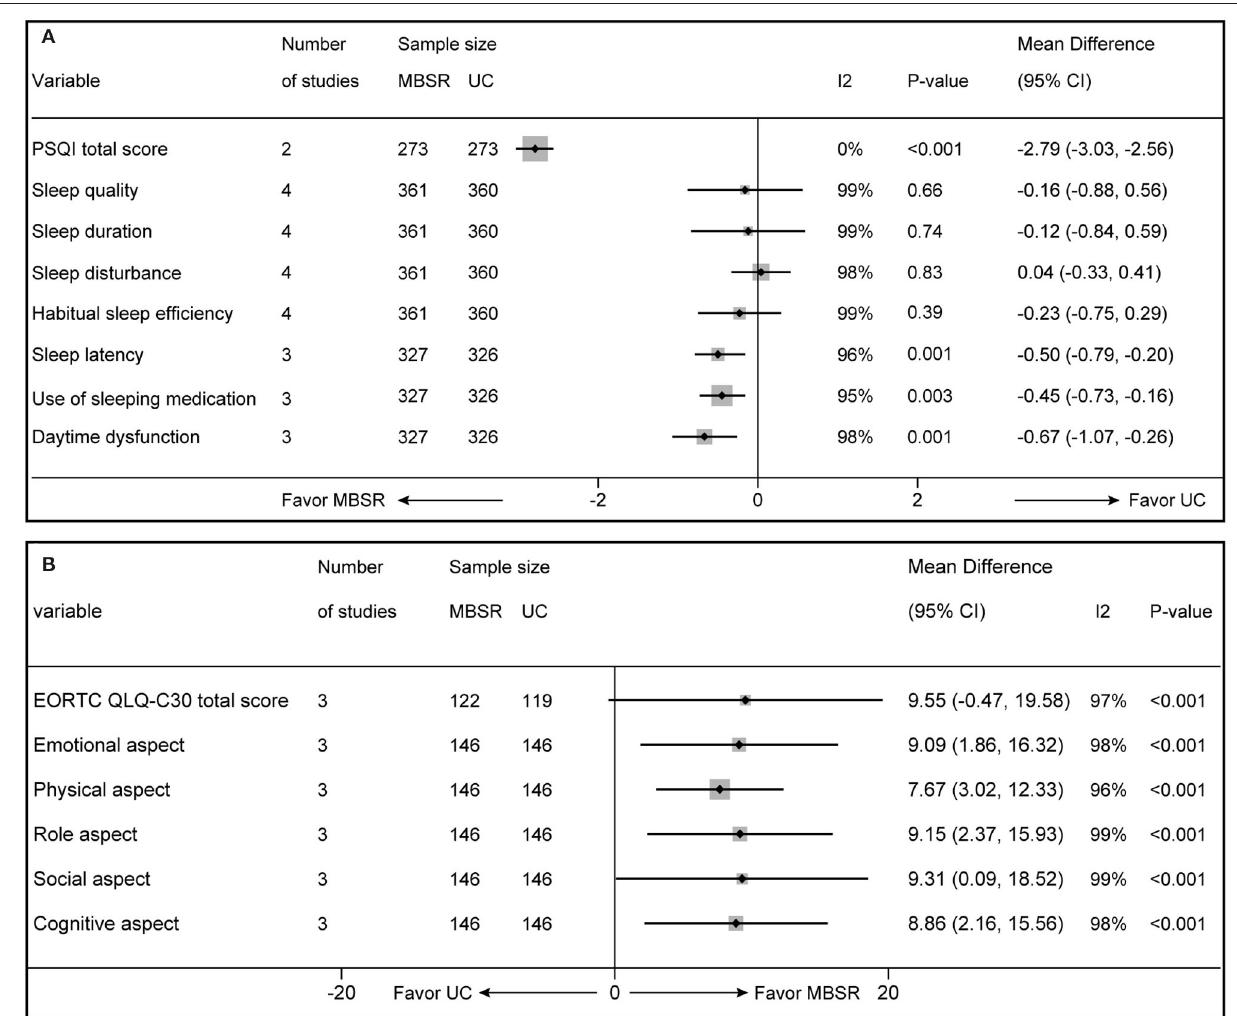
FIGURE 4 | Forest plot of comparative effectiveness between MBSR program and UC in terms of quality of sleep (A) and QoL (B) . MBSR, mindfulness-based stress reduction; UC, usual care; PSQI, Pittsburgh sleep quality index; EORTC QLQ-C30, the European Organization for Research and Treatment of Cancer Quality of Life